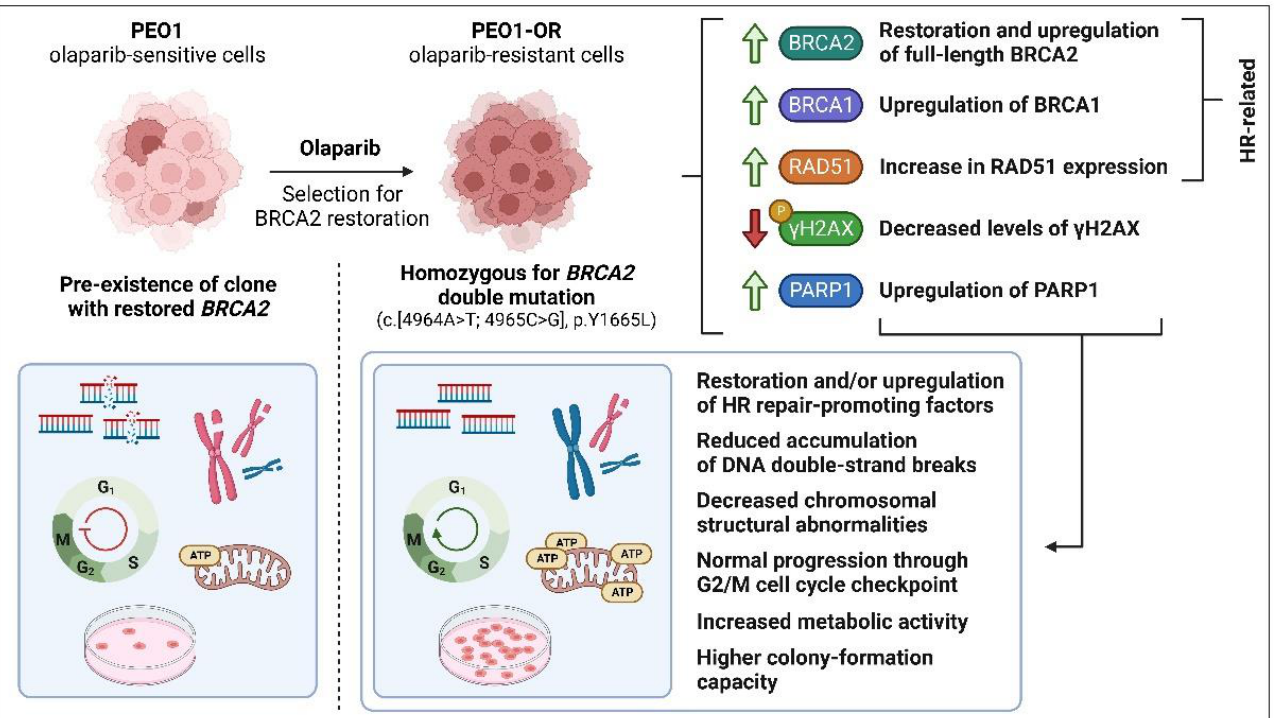
Figure 10. Co-existing mechanisms conferring resistance to olaparib in PEO1-OR BRCA2 MUT HGSOC cells. PEO1-OR cells underwent selection for BRCA2 restoration following prolonged treatment with olaparib, which led to enrichment in sub-dominant clones present in parental cells harboring the BRCA2 double mutation (c.[4964A > T; 4965C > G], p.Y1655L) removing the premature termination codon. Upregulation of BRCA2, BRCA1, RAD51, and PARP1, along with a concurrent decrease in γH2AX levels, contributed to decreased sensitivity to olaparib.